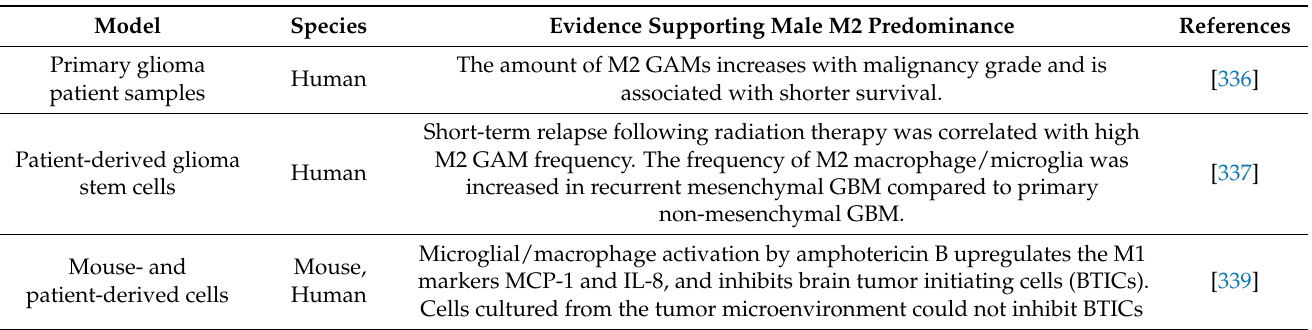
Table 7. GBM pathology is mediated by M2